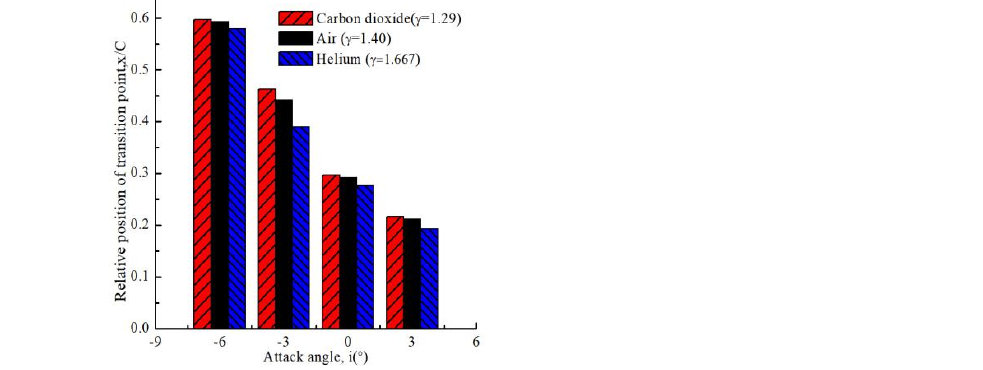
Figure 13. Relative position of transition at different attack angles (Ma = 0.7, Re = 8.0 × 105).